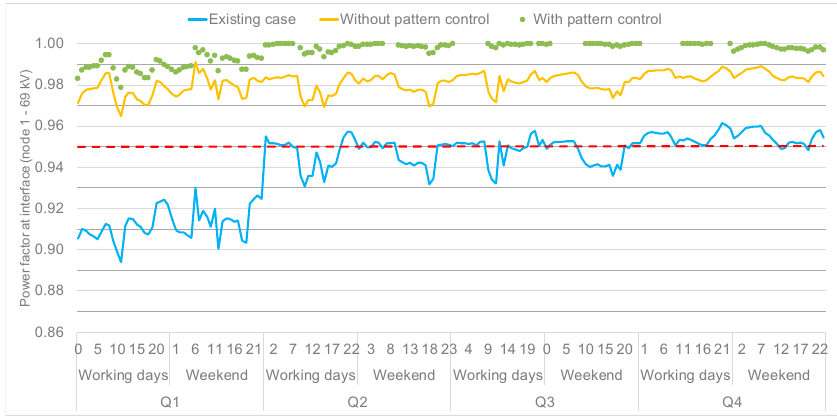
Figure 8. Case study: power factor interface profiles for the different simulations.